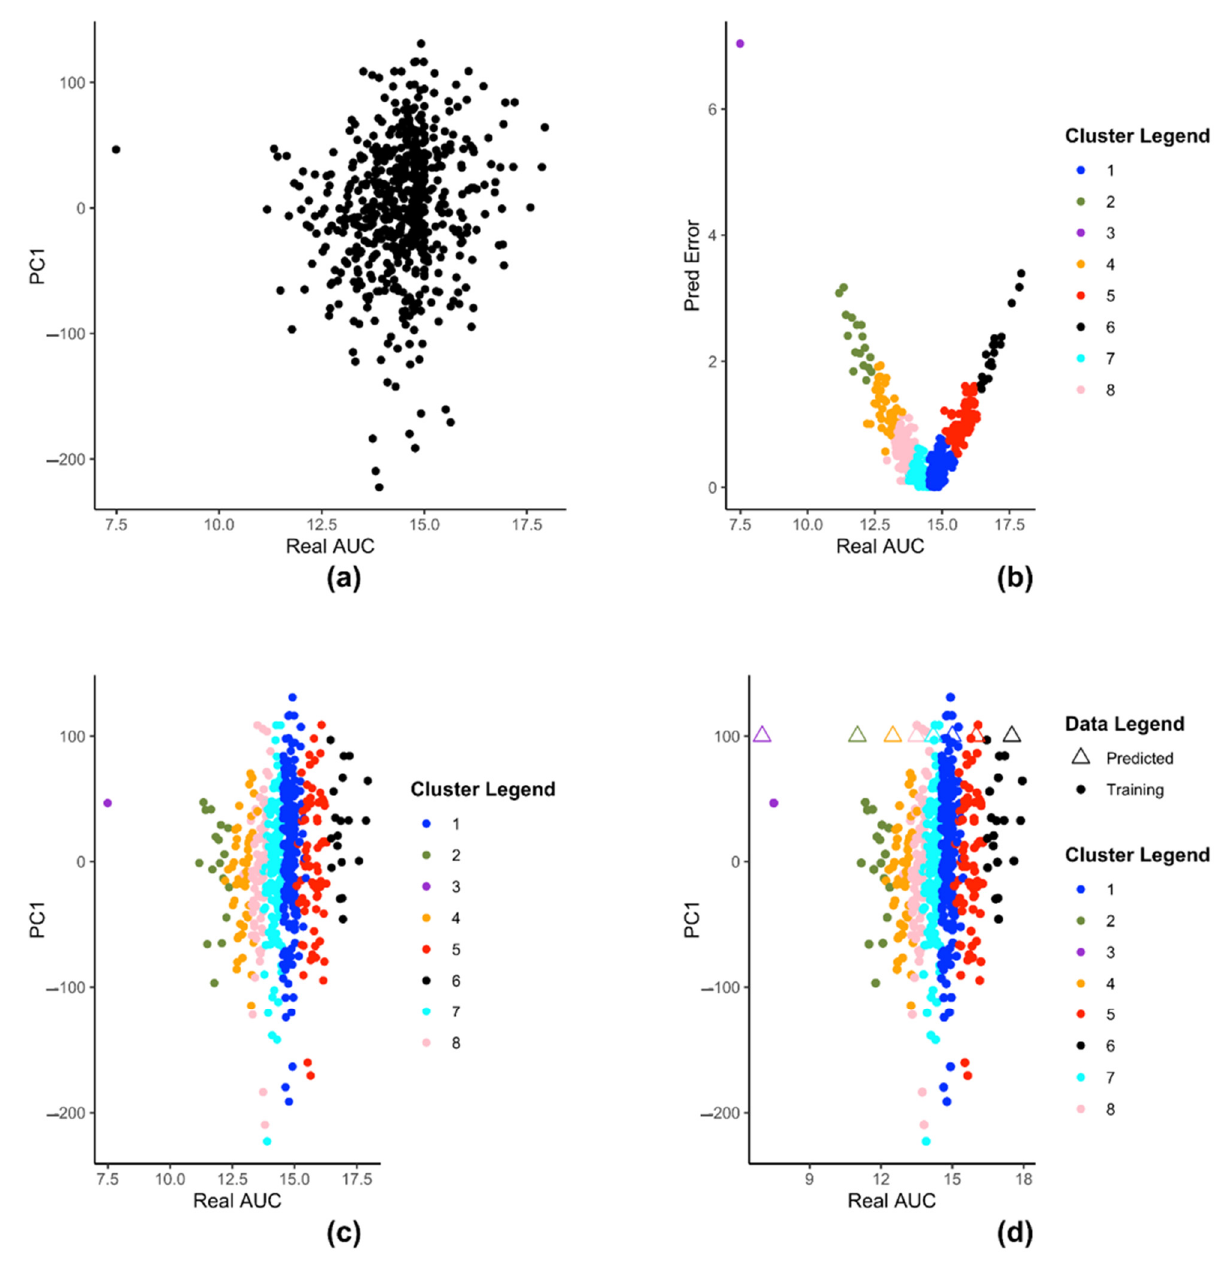
Figure 3. The steps of kESVR model creation for drug zebularine response AUC prediction on 610 cancer cells from CCLE. ( a ) Dimension reduction of gene expression profiles and mapping of the latent variable PC1 and drug response of zebularine onto 2D space. ( b ) Seeking local clusters by k-means algorithm for regression. ( c ) Construction of local SVR regression models after clustering reduced dataset Z into 8 clusters ( d ) Multiple prediction candidates from the trained 8 SVRs on the clusters.